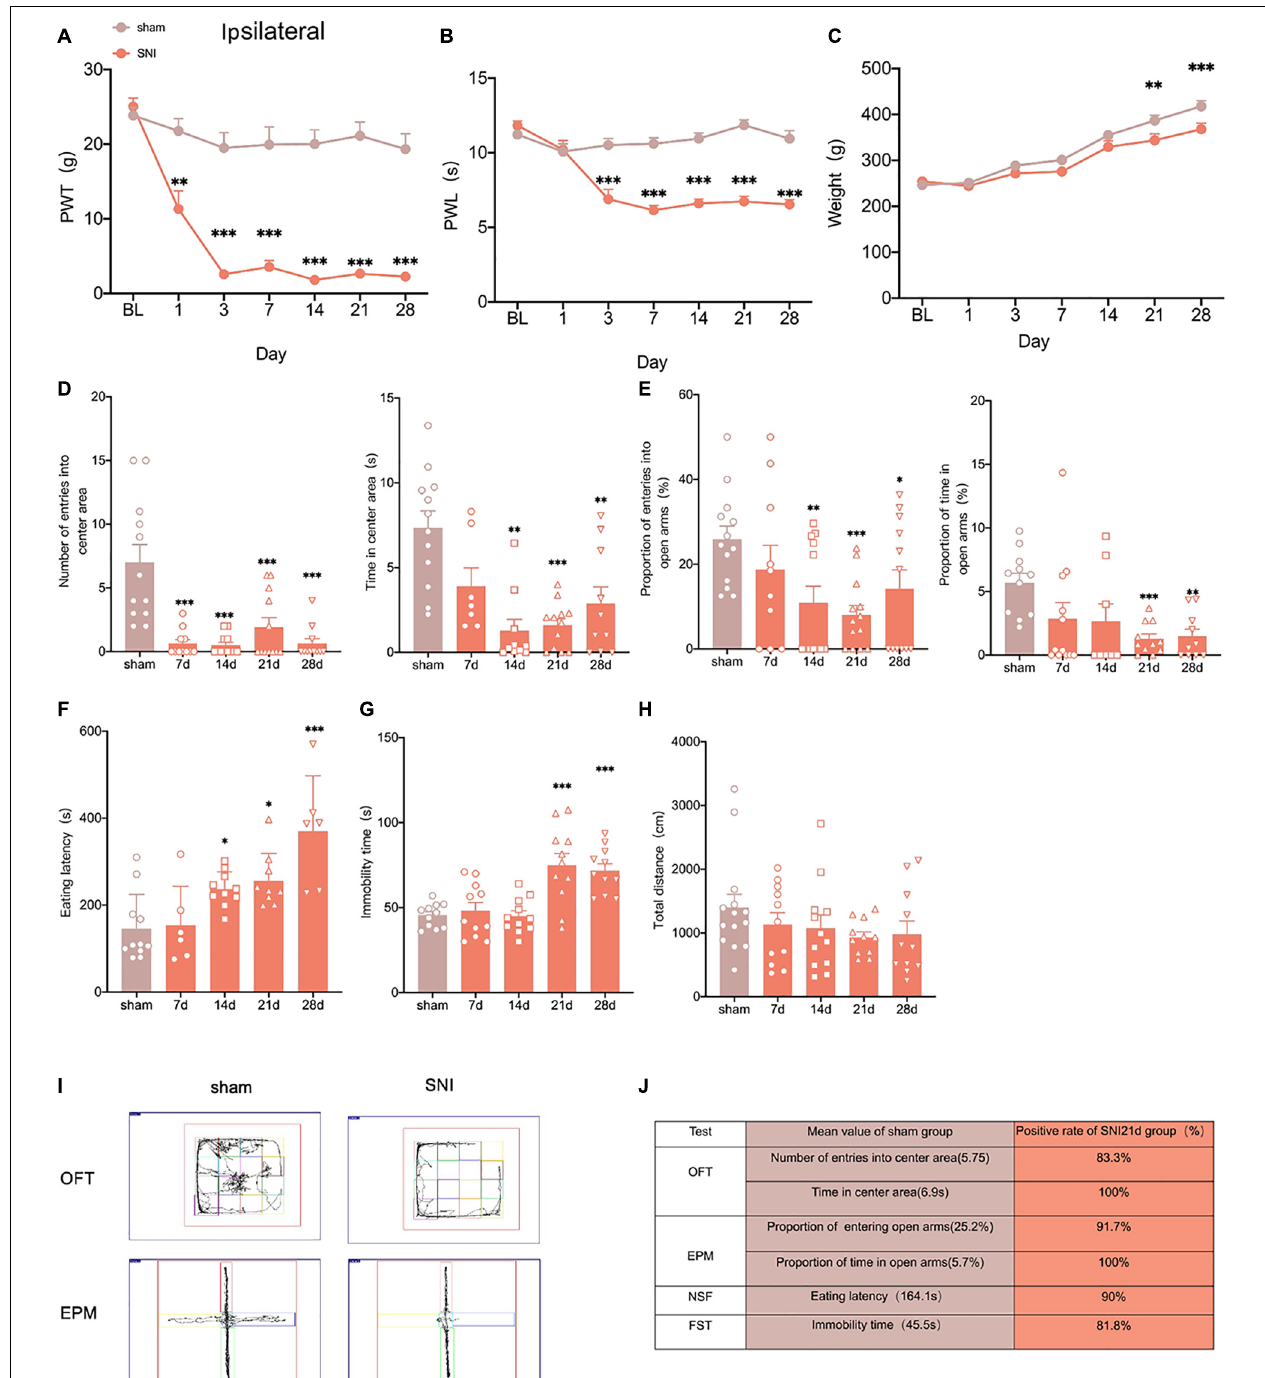
FIGURE 1 | Selectively nerve injured rats exhibit pain hypersensitivity and anxiodepression like behaviors. (A,B) SNI significantly reduced the PWT (A) and the PWL (B) in the ipsilateral paws ( n = 8 rats/group). (C) The weight growth rate of SNI rats was lower than that of sham rats ( n = 8 rats/group). (D) The rats showed a significant reduction in the number of entries into the center area and the time spent in the center area after SNI in the OFT ( n = 12 rats/group). (E) The proportion of entries into the open arms and the proportion of time in the open arms were significantly decreased in the SNI rats in the EPM ( n = 12 rats/group). (F,G) The eating latency in the NFST (F) and the immobility time in the FST (G) of SNI rats were significant increase of SNI rats ( n = 12 rats/group). (H) There was no significant difference in the total distance traveled by SNI rats in the OFT ( n = 12 rats/group). (I) Schematic representation of the locomotor trajectories of sham and SNI rats at 21 days after surgery in the OFT and EPM. (J) Probability of SNI rats exhibiting anxiety and depression like behaviors at 21 days after surgery. ∗ P < 0.05, ∗∗ P < 0.001, ∗∗∗ P < 0.0001 for sham vs. SNI.